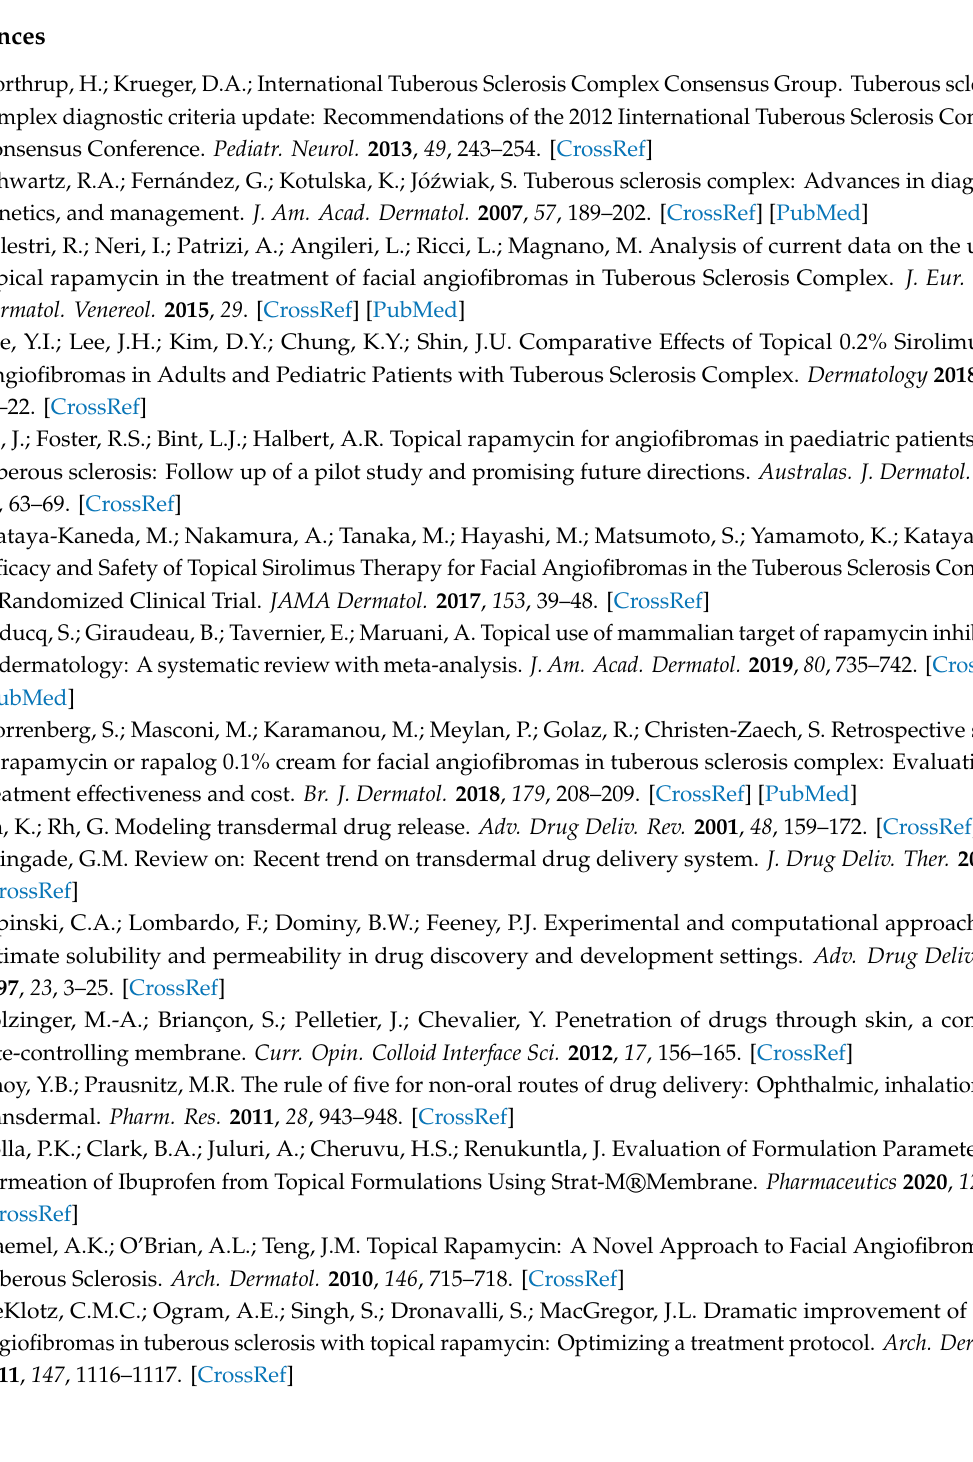
Table S1: Linearity, LOD and LOQ of the HPLC method, Table S2: Accuracy and Precision of the HPLC